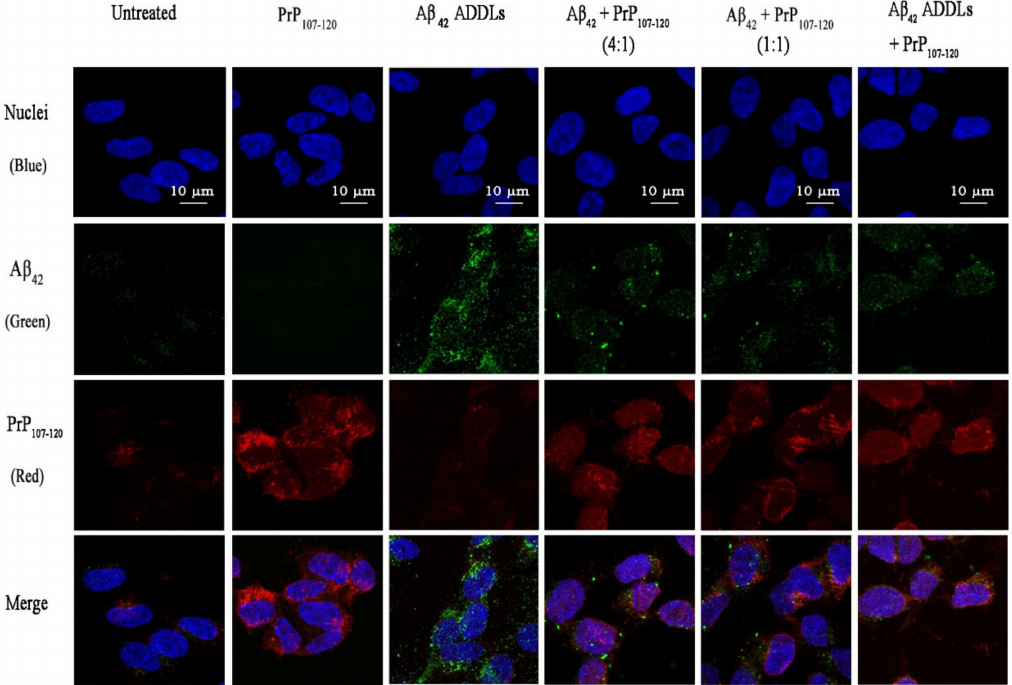
Figure 9. Absence of co-localization of A β 42 ADDLs with PrP 107–120 . Cells were treated for 1 h with the same samples described in the Figure 4 legend and indicated on top of the images (added to the cell medium). PrP 107–120 was labelled with BODIPY TMR-X NHS Ester (red fluorescence), A β 42 ADDLs with mouse monoclonal primary antibody 6E10 and a secondary antibody (green fluorescence) and the nuclei with the Hoechst dye (blue florescence). Scale bar = 10 µ